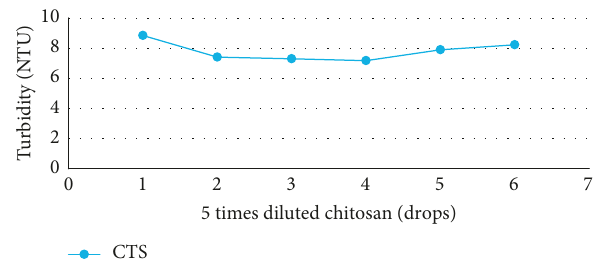
Figure 2: Turbidity of raw water of tap water treated with chitosan.